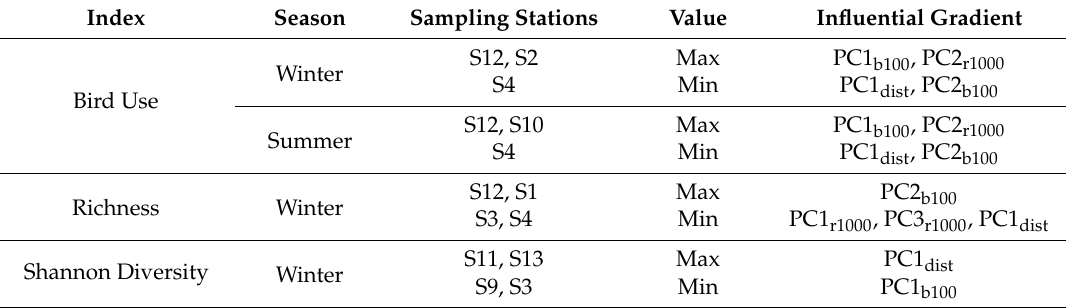
Table 4. Waterbird community indices and the influential gradient affecting them as defined by the maximum and minimum values reached by these indices in sampling stations and by the clear association of these extreme stations with environmental gradients (from PCA